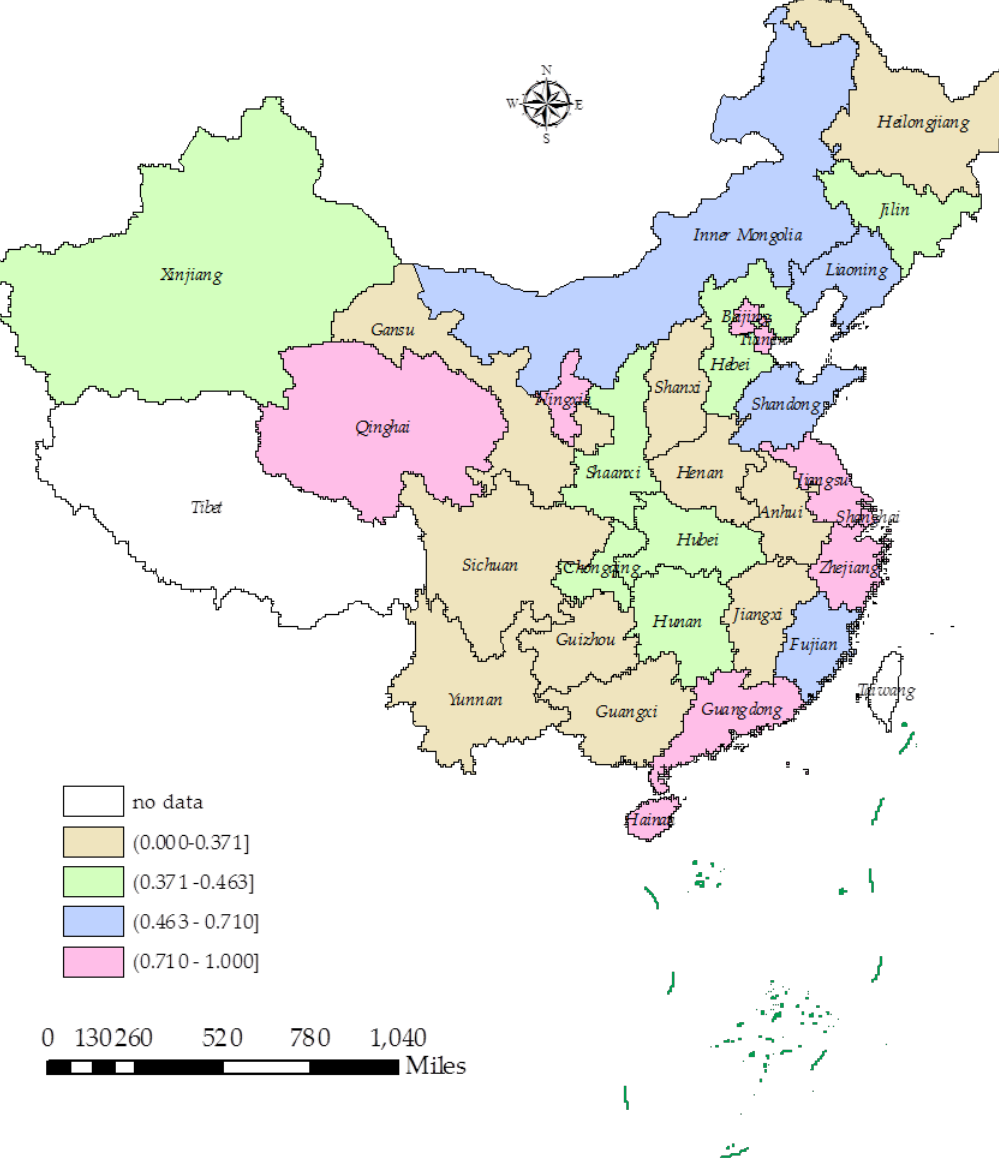
Right one Figure 3. Spatial distribution of water use efficiency in China during